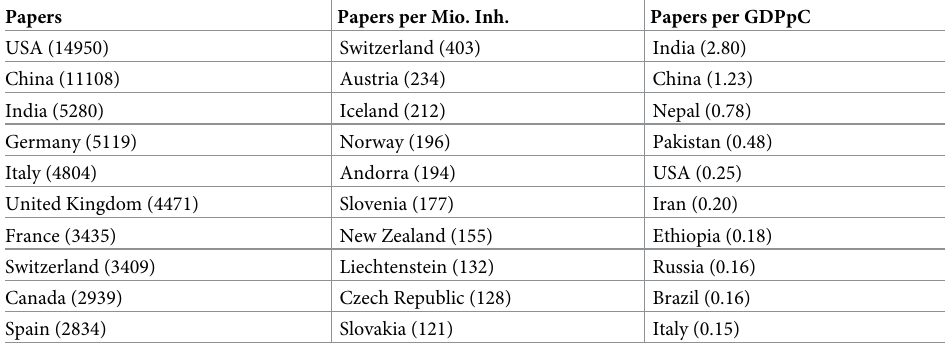
Table 3. Top 10 results of country paper contributions absolute, per Mio. capita (average values for period) and per GDP ($) per Capita (GDPpC; average values for period) for the period 2015–2019. Exact values in brackets.